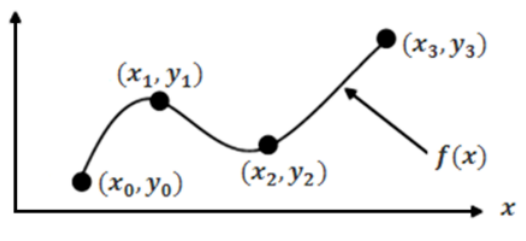
Figure 4. Interpolation of discrete